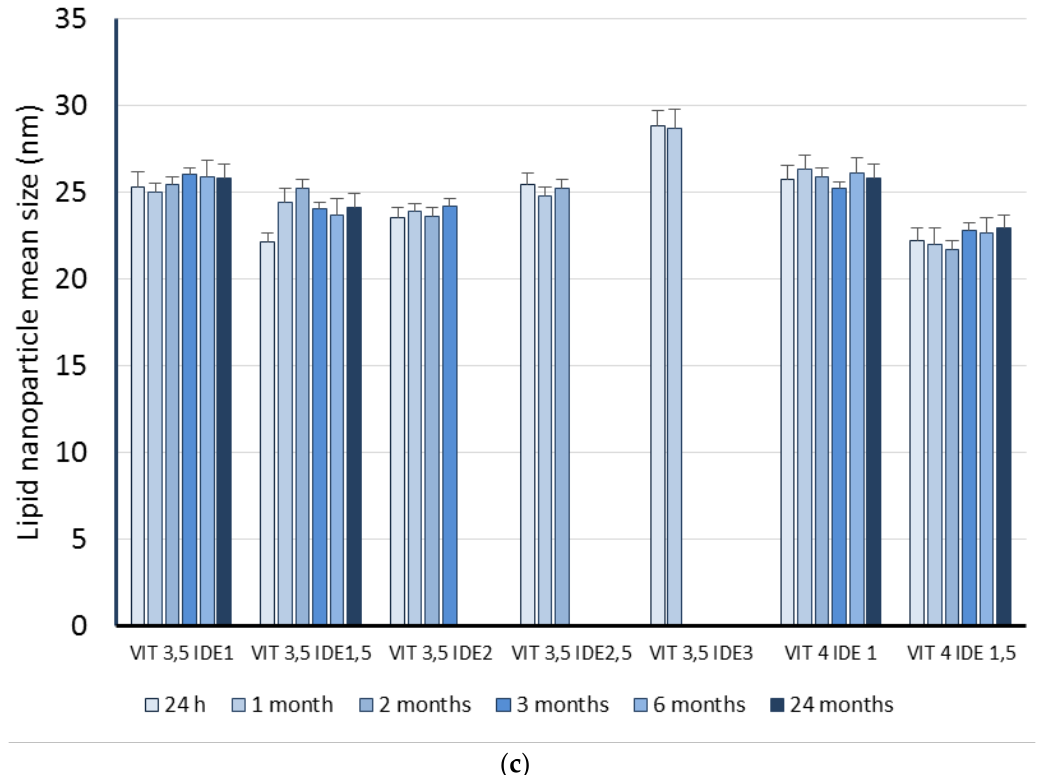
Figure 5. Mean sizes of idebenone (IDE)-loaded SLN and NLC during storage at room temperature for 12 months. ( a ) SLN loaded with IDE 1% w / w and NLC containing tocopheryl acetate 1% or 2% w / w and different percentages of IDE (VIT 1 IDE1, VIT 1 IDE1,5, VIT 2 IDE1, VIT 2 IDE1,5); ( b ) NLC containing tocopheryl acetate 3% and different percentages of IDE (VIT 3 IDE1, VIT 3 IDE 1,5, VIT 3 IDE 2, VIT 3 IDE 2,5, VIT 3 IDE 3); ( c ) NLC containing tocopheryl acetate 3.5% or 4% w / w and different percentages of IDE. No bars are shown in the plot when nanoparticle mean size was not determined, owing to the presence of a precipitate in the colloidal suspension. Each stability test was performed in triplicate.